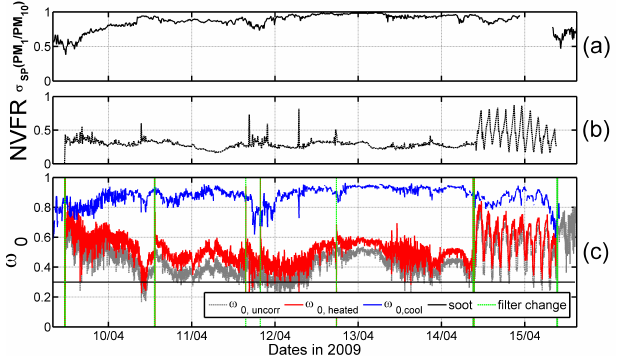
Fig. 4. (a) The contribution by sub-micron particles to total (a) The contribution by sub-micron particles to total scattering values ( σ SP (PM 1 )/ σ SP (PM 10 )) from DMPS and APS data using the refractive index of sulphuric acid (1.426+0.05i), scattering values ( σ SP (PM 1 )/ σ SP (PM 10 )) from DMPS and APS (b) non-volatile volume fraction remaining (NVFR), and (c) single- data using the refractive index of sulphuric acid (1.426+0.05i), scattering albedo ω 0 of the heated and the cool urban aerosol calcu- (b) non-volatile volume fraction remaining (NVFR), and (c) single- lated at 880nm and at 545nm respectively. ω 0 , heated was corrected scattering albedo ( ω 0 ) of the heated and the cool urban aerosol cal- according to Nakayama et al. (2010) and ω 0 , uncorr without this cor- rection. The line at ω 0 =0.3 is the ω 0 of laboratory generated pure culated at 880nm and at 545nm respectively. ω 0 , heated was cor- soot (Mikhailov et al., 2006). rected according to Nakayama et al. (2010) and ω 0 , uncorr without this correction. The line at ω 0 =0.3 is the ω 0 of laboratory generated pure soot (Mikhailov et al.,